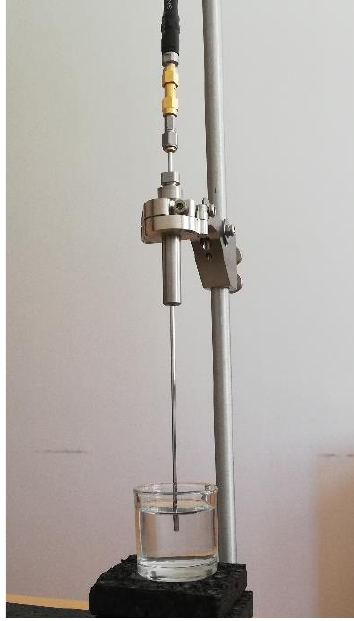
Figure 1. The slim form inserted into a liquid MUT.